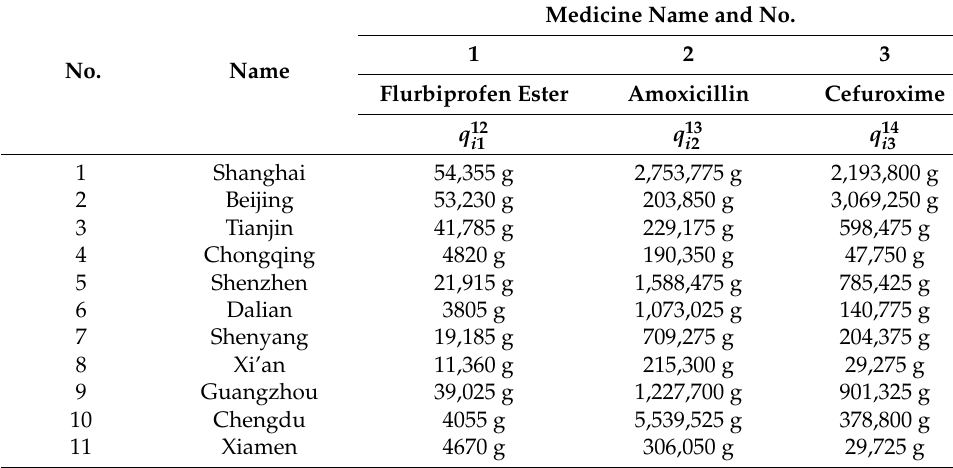
Table 3. Medicine delivery volume in each city (10 4 ).